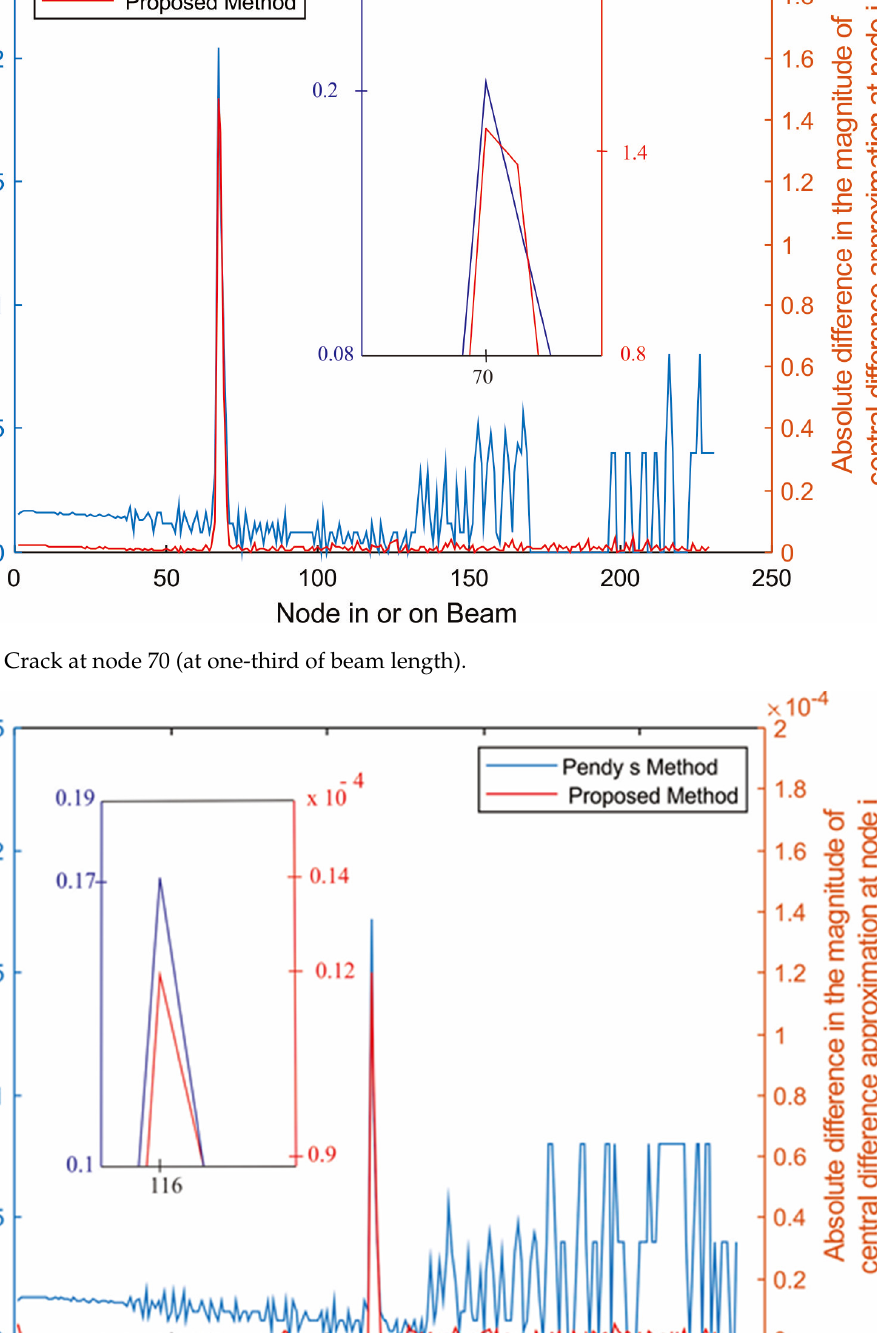
Figure 8. Crack at node 163 (at two-thirds of beam length).